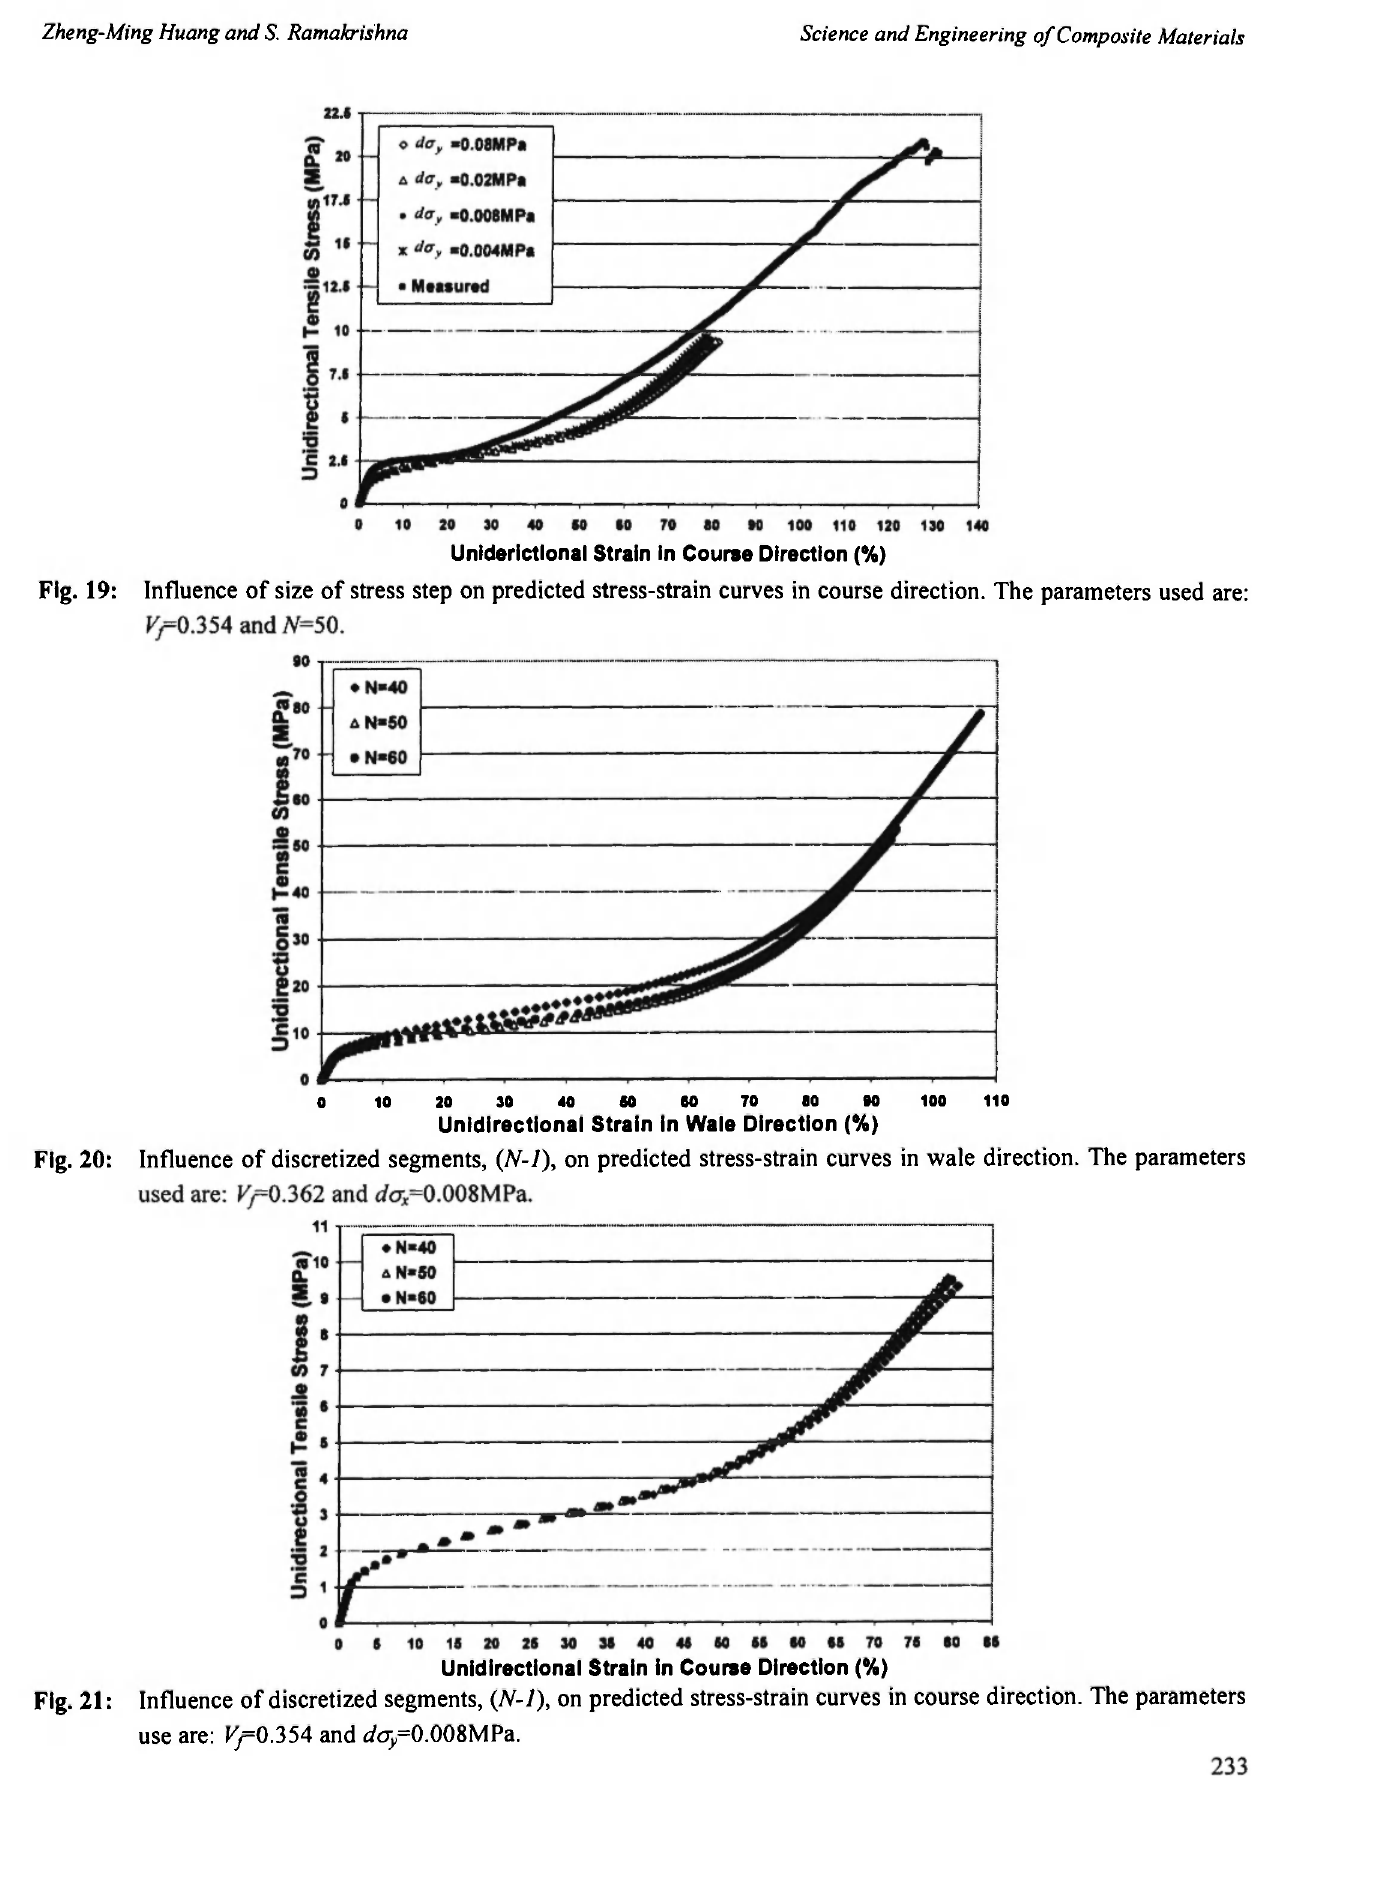
Fig. 19: Influence of size of stress step on predicted stress-strain curves in course direction. The parameters used are: